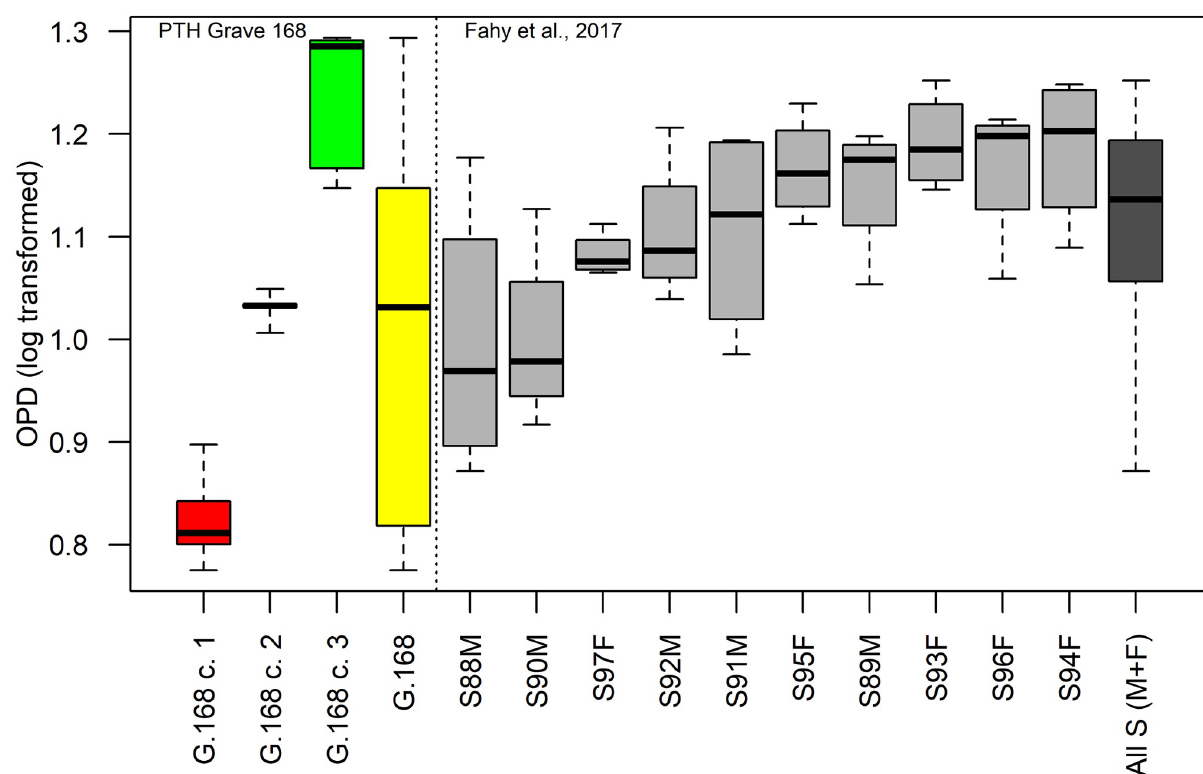
Fig 9. Comparison of the logtransformed OPD values from the human cremated samples of the Tomb of Nestor’s Cup and the logtransformed OPD individual values in long bones following [58]. The box and whisker plots of the Tomb 168 lontransformed OPD values by the three clusters (cluster 1, red ; cluster 2, black ; cluster 3, green ) and the whole range of variation ( yellow ) compared to the logstransformed OPD published data ( grey ) from 10 adults (5 males and 5 females). The whisker plot shows a narrower range of variation amongst the published subset comparing to OPD values from Tomb